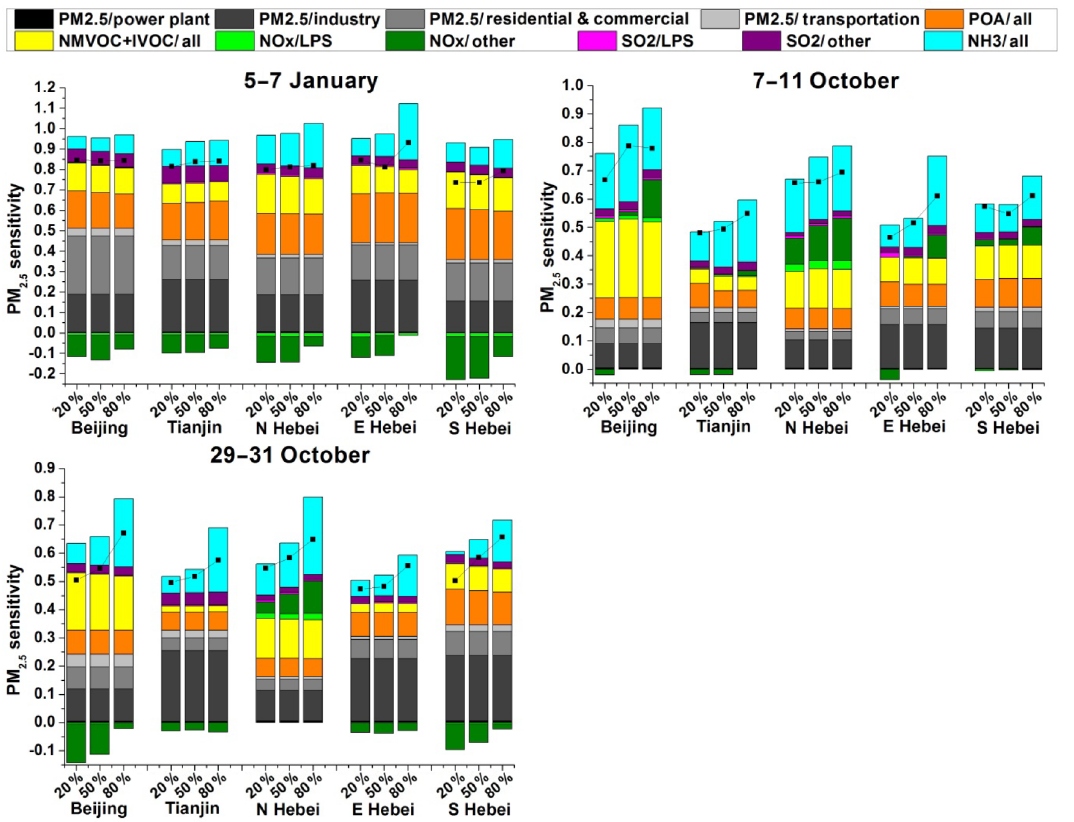
Figure 9. Sensitivity of PM 2 . 5 concentrations to the stepped control of individual air pollutants from individual sectors during three heavy- pollution episodes. The meanings of x axis, y axis, colored bars, and black dotted lines are the same as in Fig. 4.